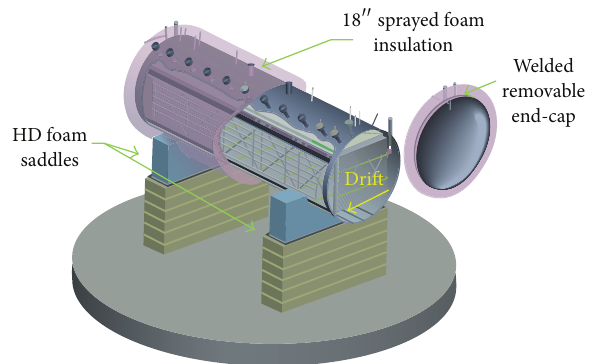
Figure 11: (Color online) A drawing of MicroBooNE cryostat [53]. The 170 ton cryostat contains the 89 ton